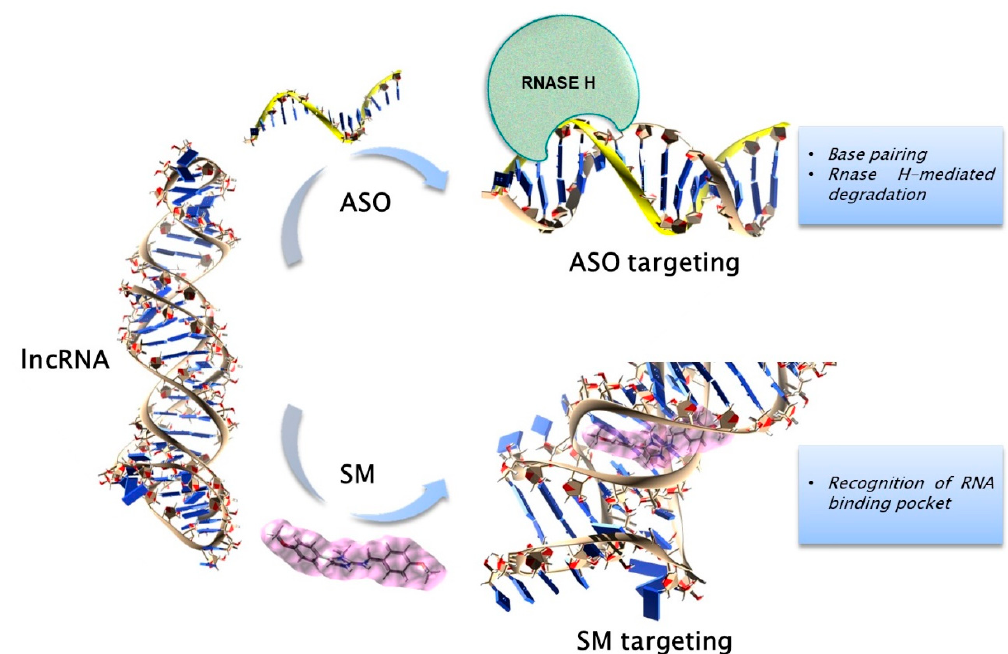
Figure 2. Strategies for lncRNA targeting. The picture reports, as a representative model, the triple helix region of the lncRNA MALAT1, which can be targeted or by LNA gapmeR ASO, that binds the lncRNA by perfect complementarity and triggers the RNAse H-mediated degradation (upper part), or by an SM designed to specifically recognize an RNA binding pocket (bottom part).